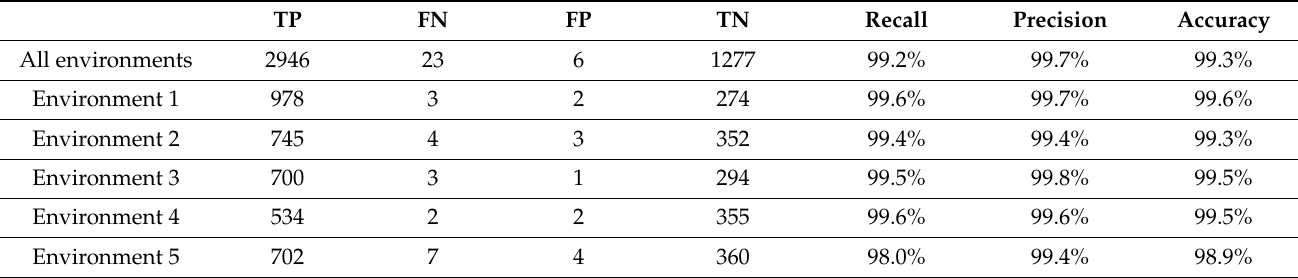
Table 2. Predictions of the proposed